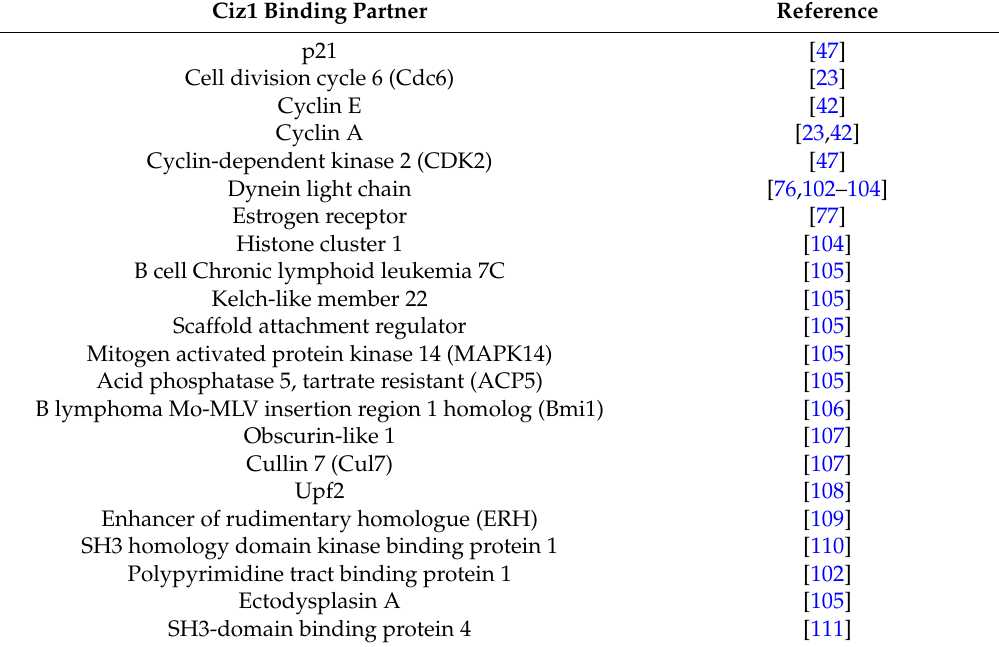
Table A1. A list of the Ciz1 interaction partners. This table was collated from published works and identifies human and mouse interaction partners, sourced from literature and BioGrid